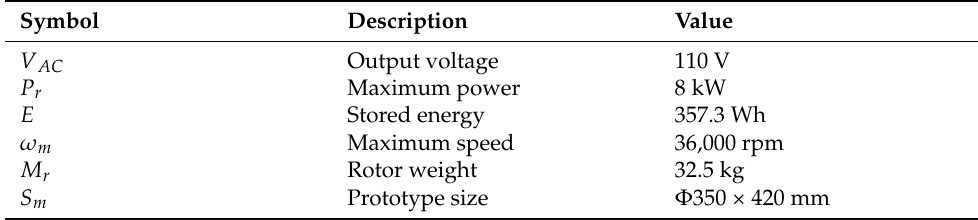
Table 1. The main specifications of the FESS prototype.